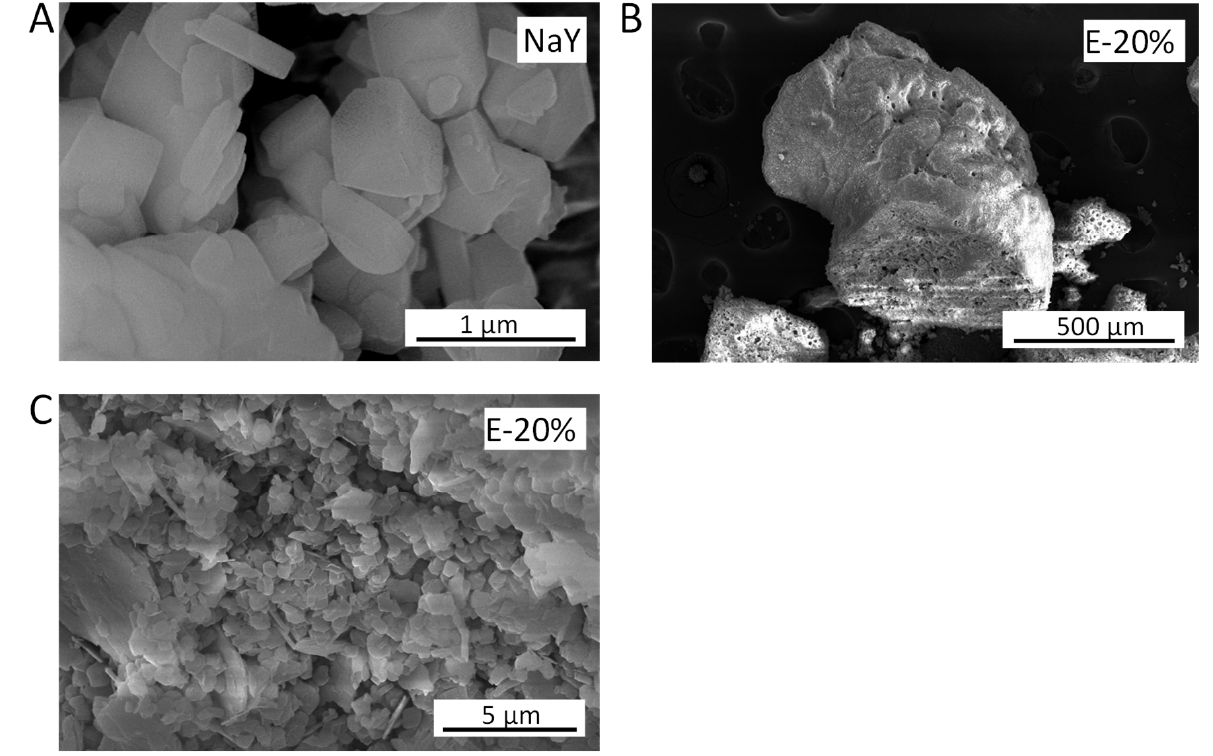
Figure 3. XRD patterns of F1-beads, F2-beads, and F3-beads. Peaks indicated with an asterisk corre-